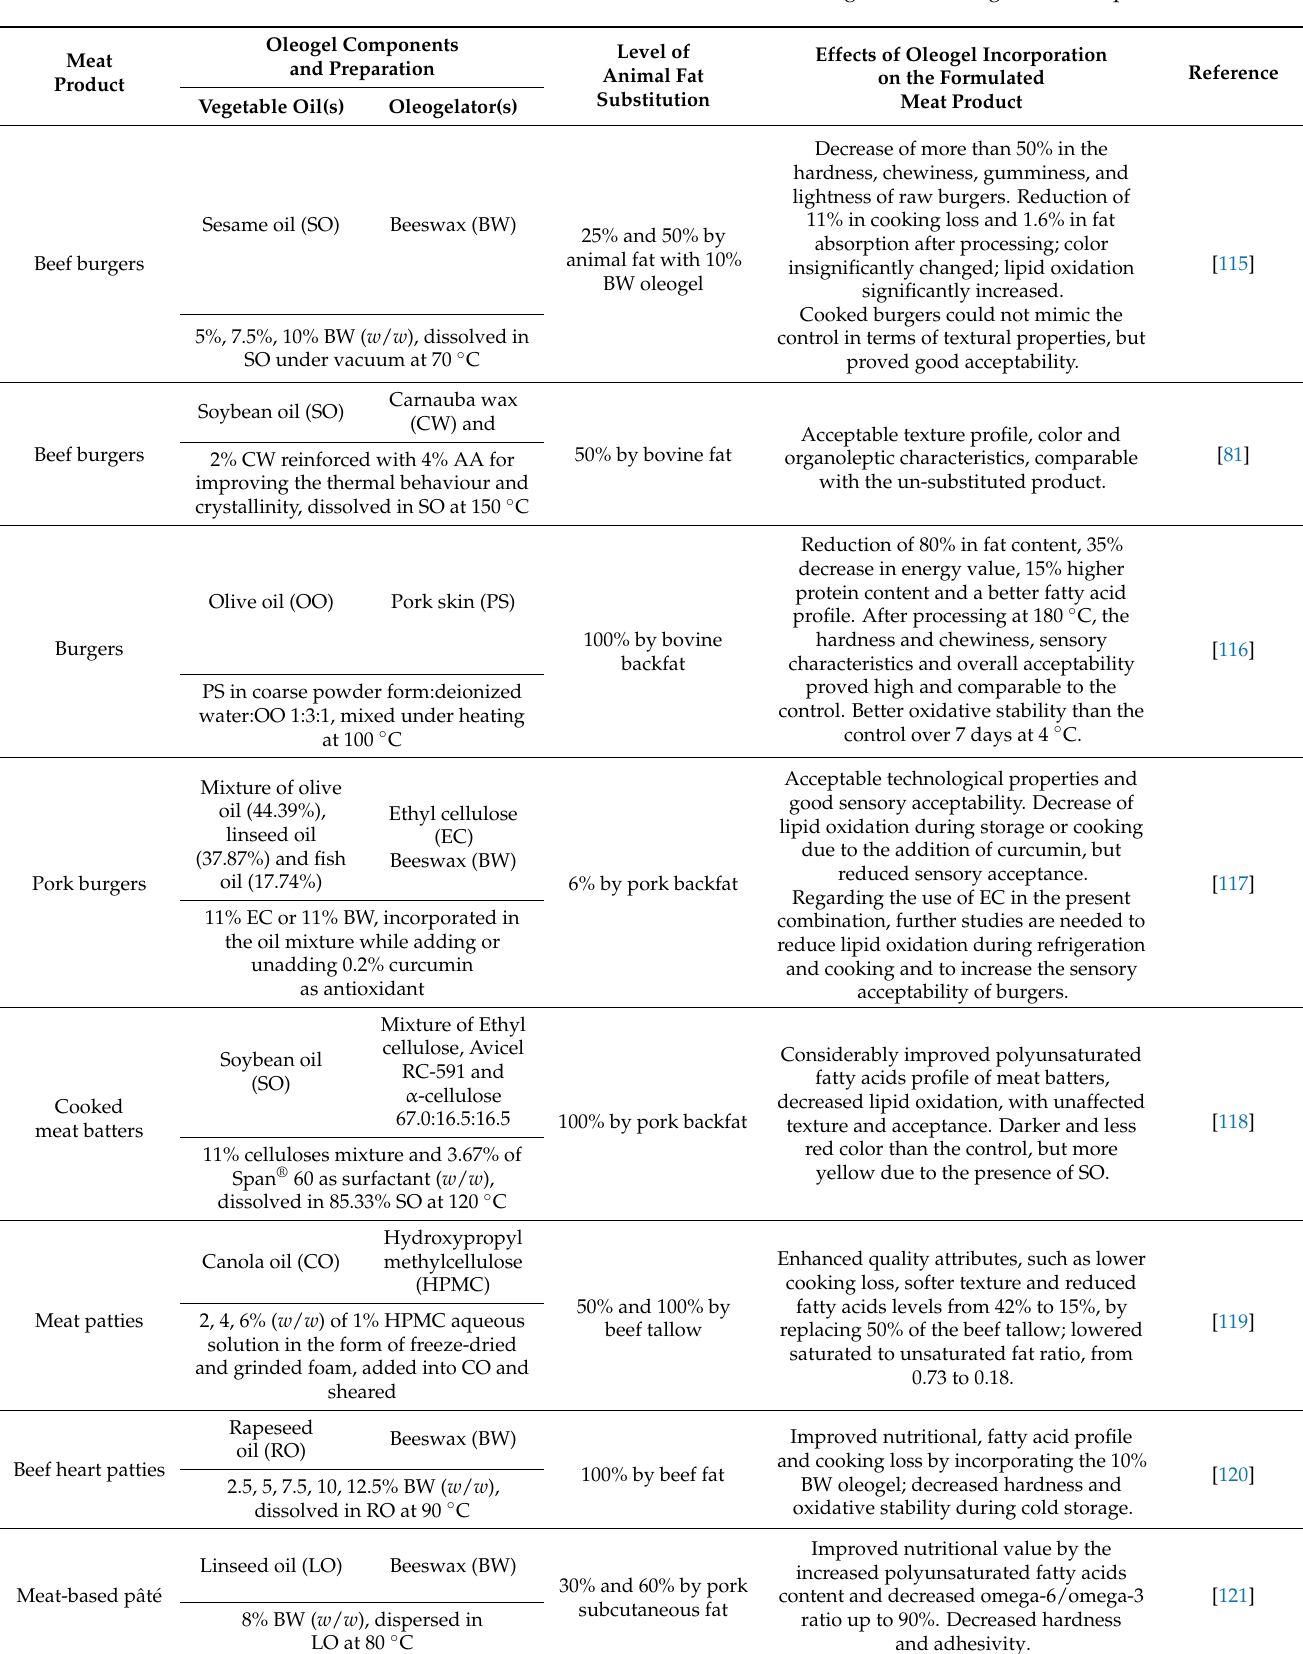
Table 3. Overview of some recent studies on the integration of oleogels in meat